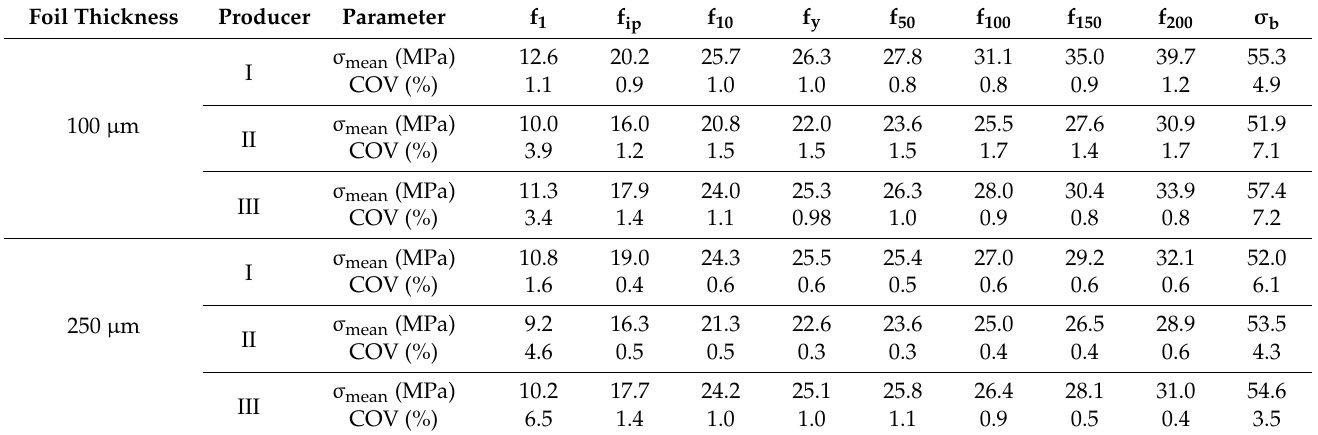
Table 3. Mean stress values per test series at specific characteristics and their COV at T 23 and . ε . v 100 ∼ = 200